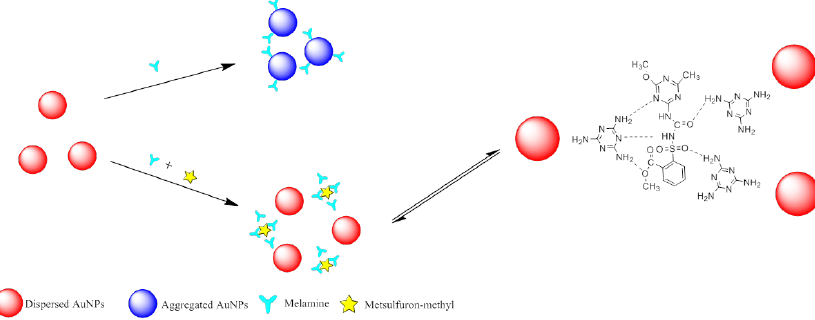
Figure 4. Schematic illustration of colorimetric sensing of metsulfuron-methyl based on anti- aggregation of gold nanoparticles in the presence of melamine.